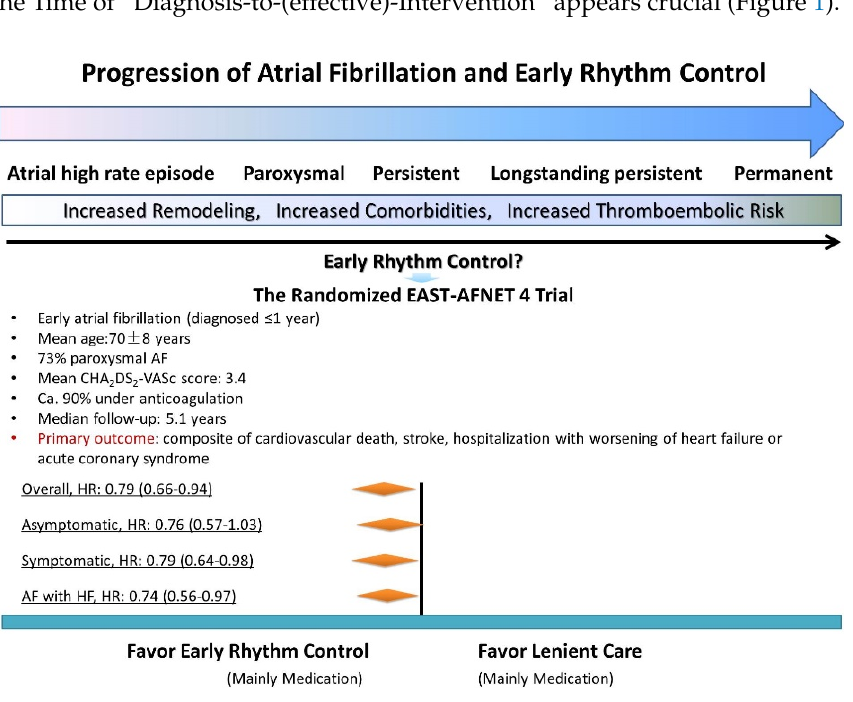
Figure 1. Progression of Atrial Fibrillation and Early Rhythm Control.